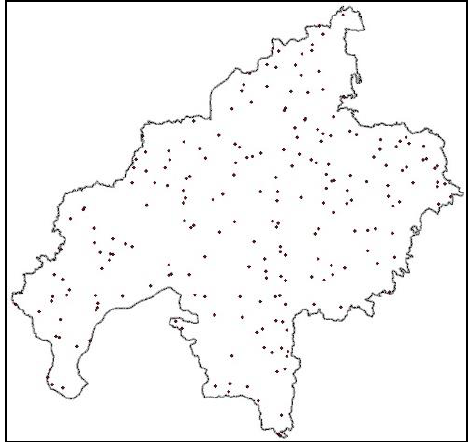
Figure 7. Distribution of random samples